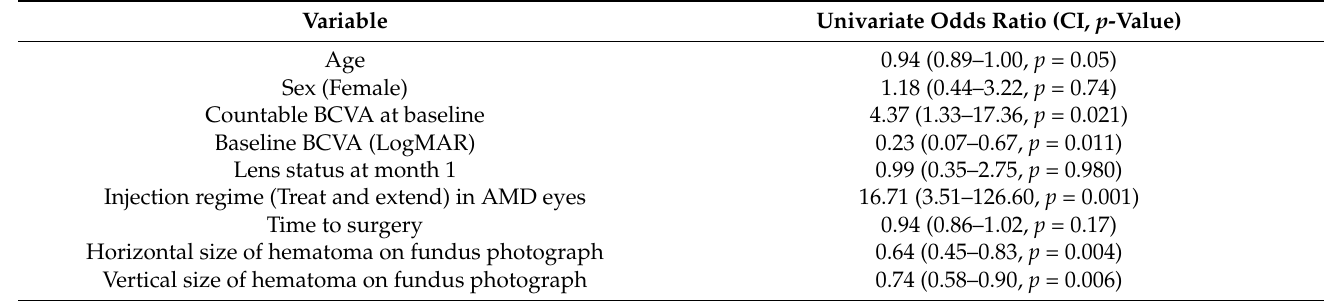
Table 2. Predictive factors of obtaining a countable visual acuity at one month of